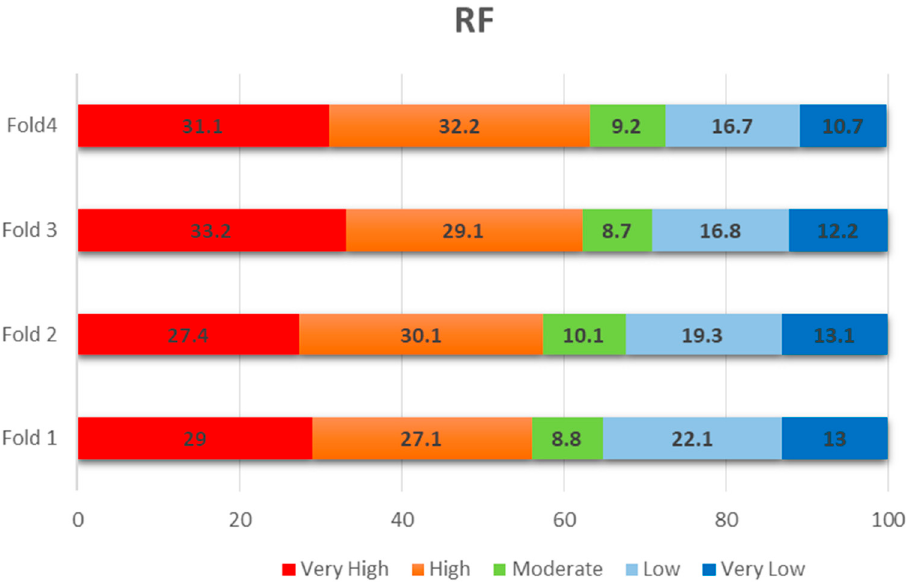
Figure 10. Participation percentage of ranges on validation areas for all ML approaches.